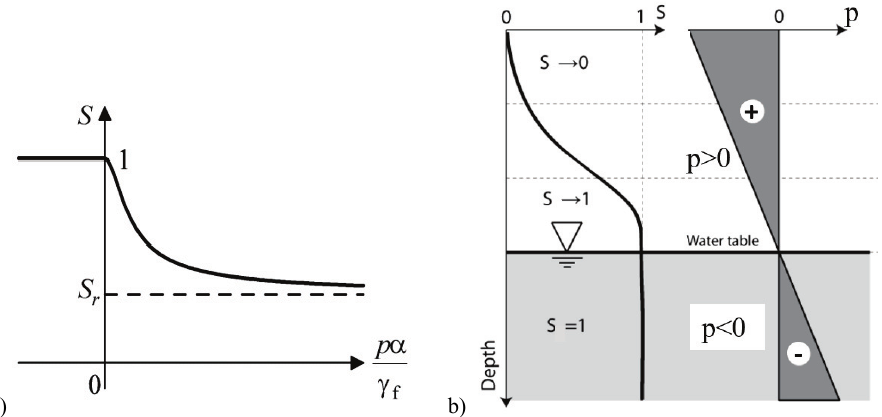
Fig. 12. Graphical representation of partially saturated medium: (a) soil water retention curve by van Genuchten’s model, and (b) schematic representation of the partially saturated zone above the ground water table